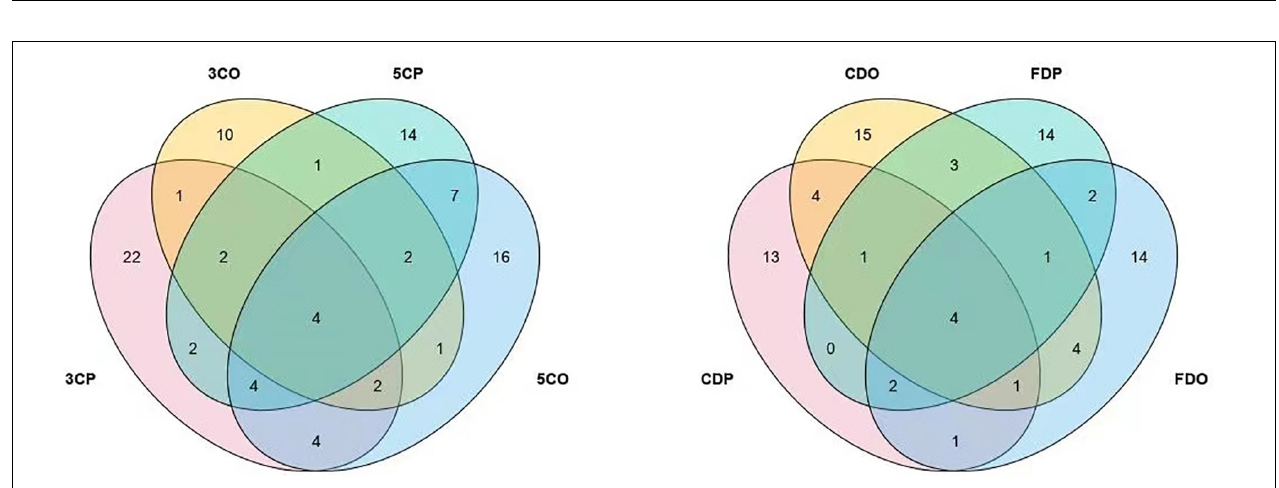
FIGURE 8 | Venn diagram showing the comparative fungal species isolated from the peak and off-peak periods at different canteens (left) and dormitories (right).